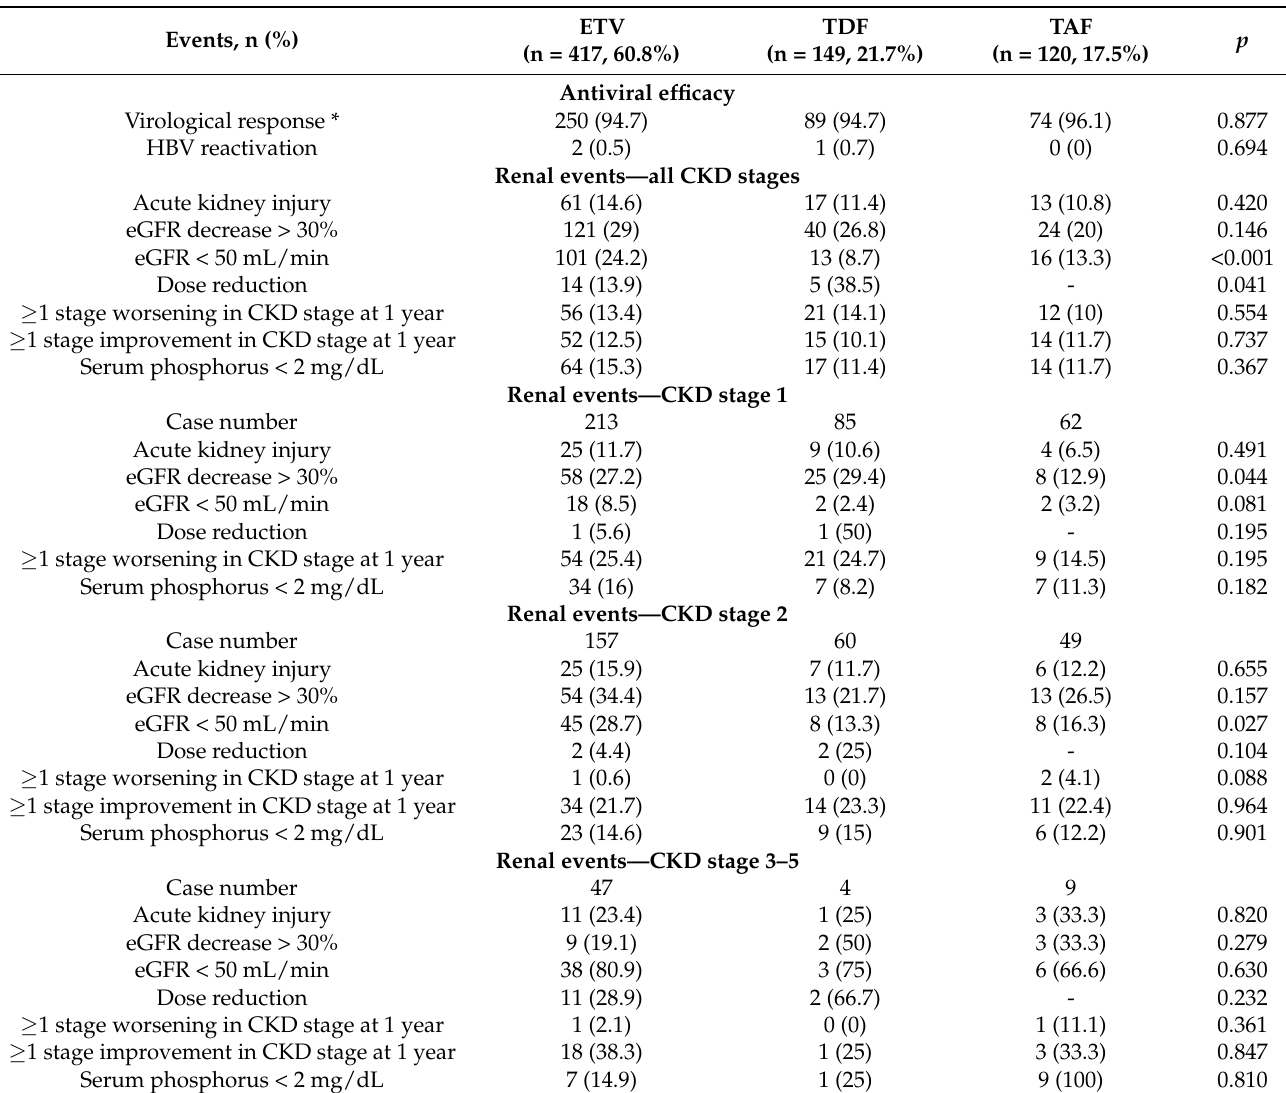
Table 2. Antiviral efficacy and incidence of renal events at 1 year after starting NUC therapy in 686 patients with follow-up of more than 1